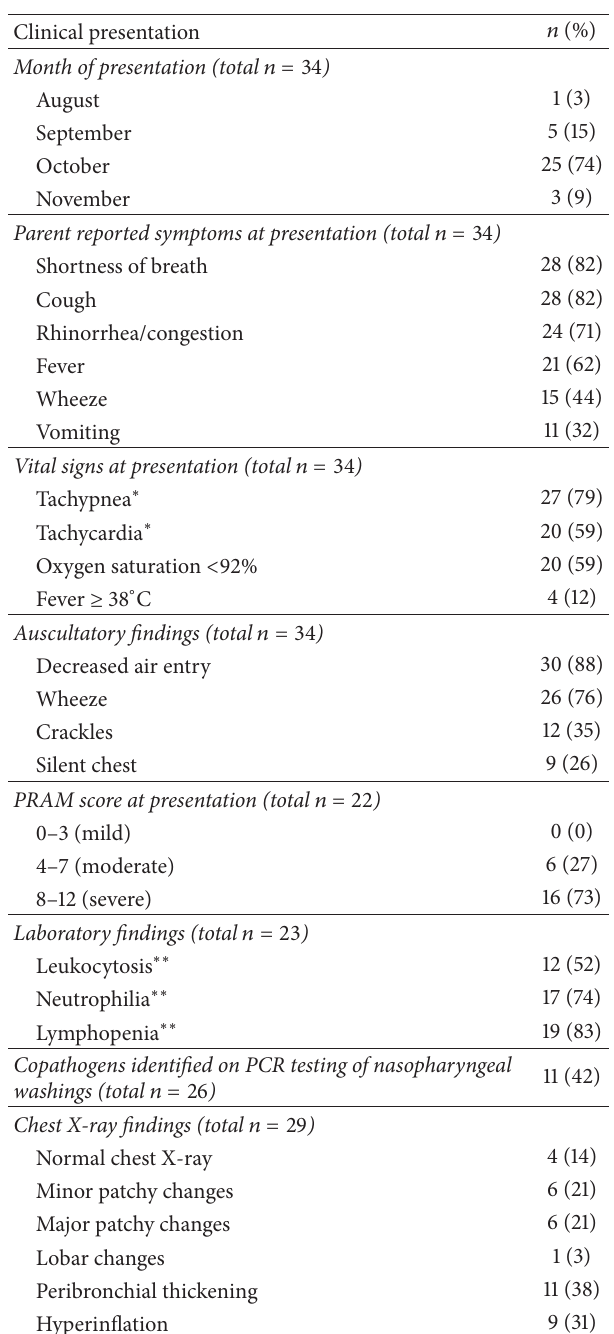
Table 2: Clinical presentation of hospitalized children with EV- D68.